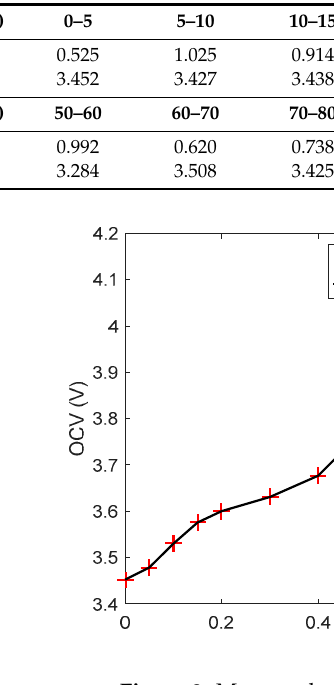
Table 3. Piecewise linear fitting results.